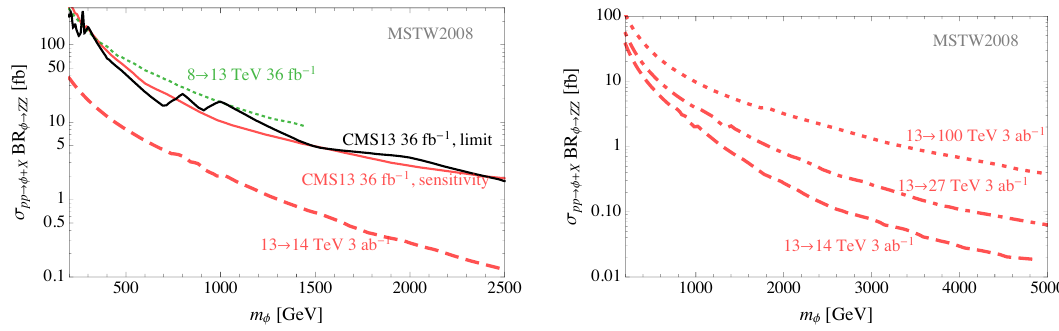
Figure 14. Sensitivities on the signal cross-sections of a new resonance decaying into ZZ , at the high-luminosity (dashed) and high-energy (dot-dashed) LHC, and at the FCC-hh (dotted). They are derived from the present LHC sensitivity at 13 TeV with 36 fb (cid:0) 1 of luminosity [53] (continuous red), see text for more details. For comparison, we also show the 13 TeV limit corresponding to the sensitivity of ref. [53] (continuos black), and the sensitivity that one would obtain at 13 TeV with 36 fb (cid:0) 1 , rescaling the 8 TeV searches [104]. The latter serves as a rough validation of our